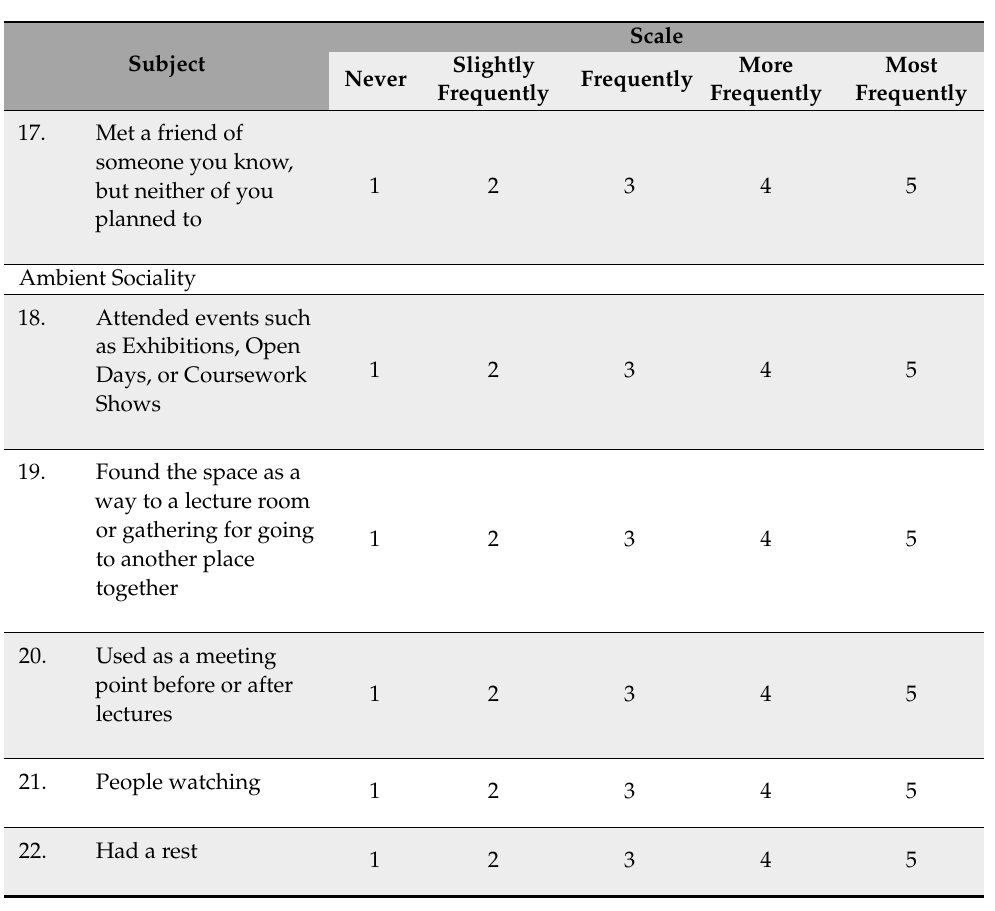
b. During what time do you regularly use this social space? Please tick ( (cid:88) ) the time period when you use social spaces. You can tick ( (cid:88) ) more than one.